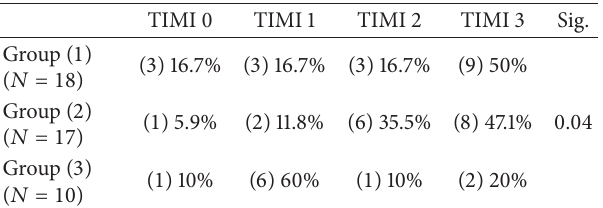
Table 2: TIMI flow grade in primary PCI cases ( 𝑛 = 45 ).